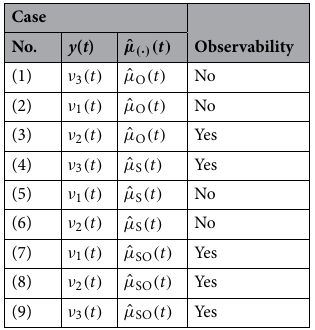
Table 1. Results of analysis based on differential geometry